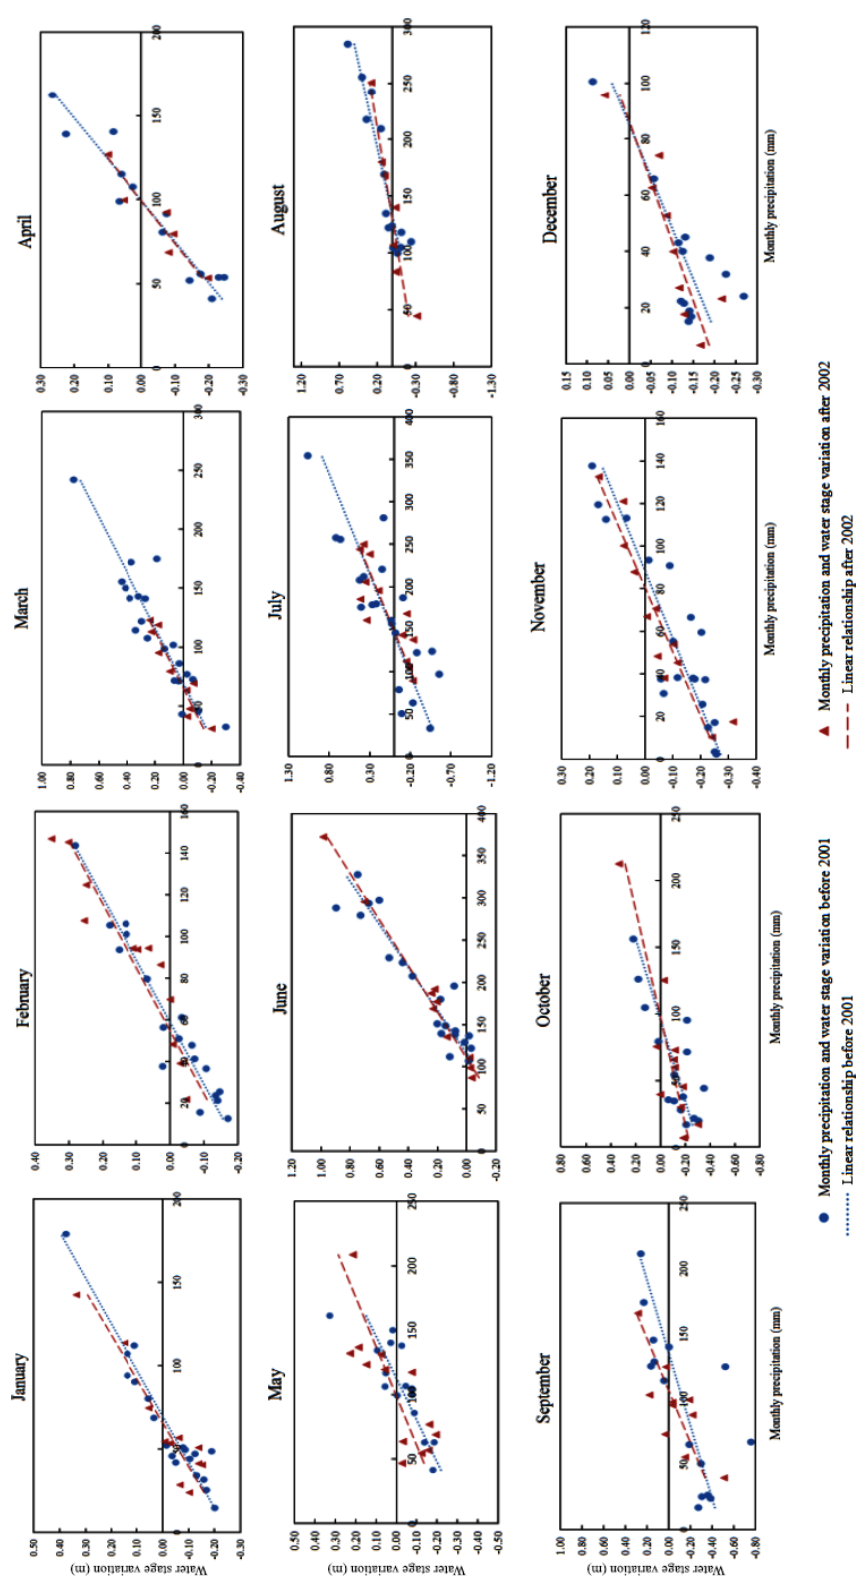
Figure 6. Relationships between monthly precipitation and water stage variation before 2001 and after